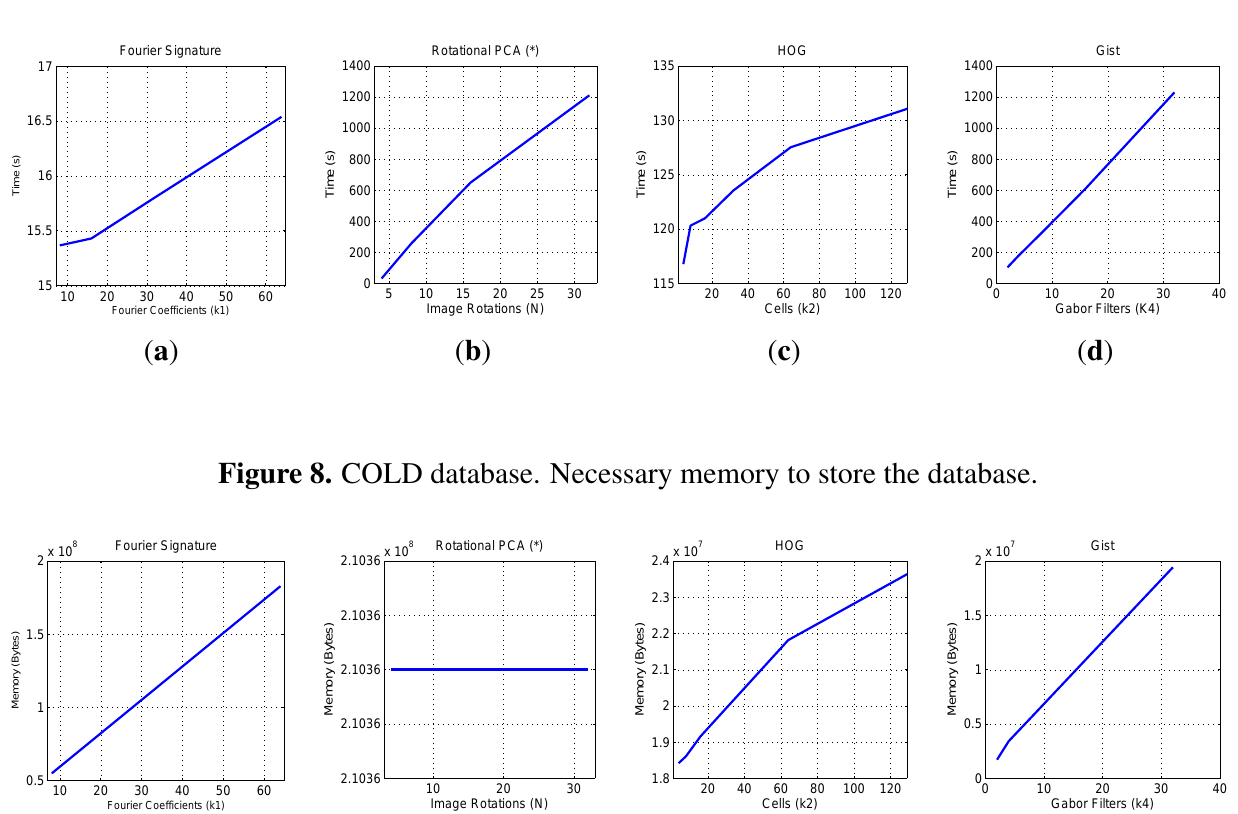
Figure 7. COLD database. Necessary time to compute the representation (map) of the environment.